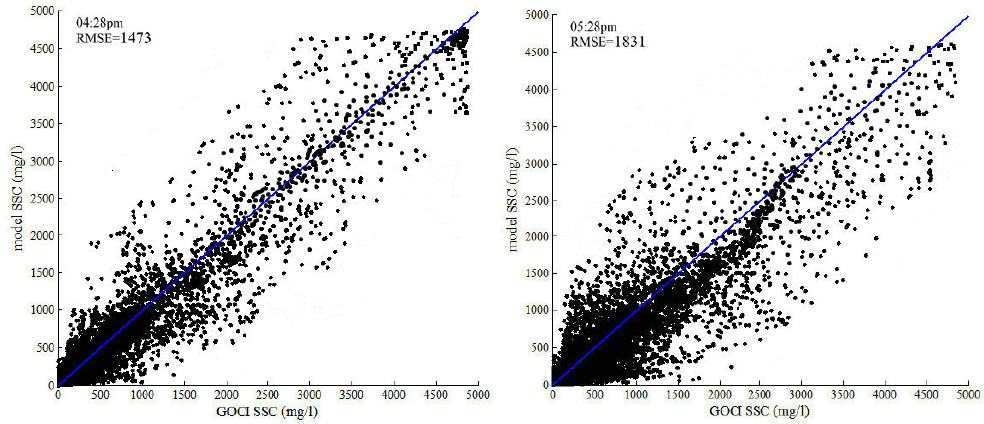
Figure 7. Scatter plots showing the comparison of individual simulated surface SSC with GOCI-derived SSC.